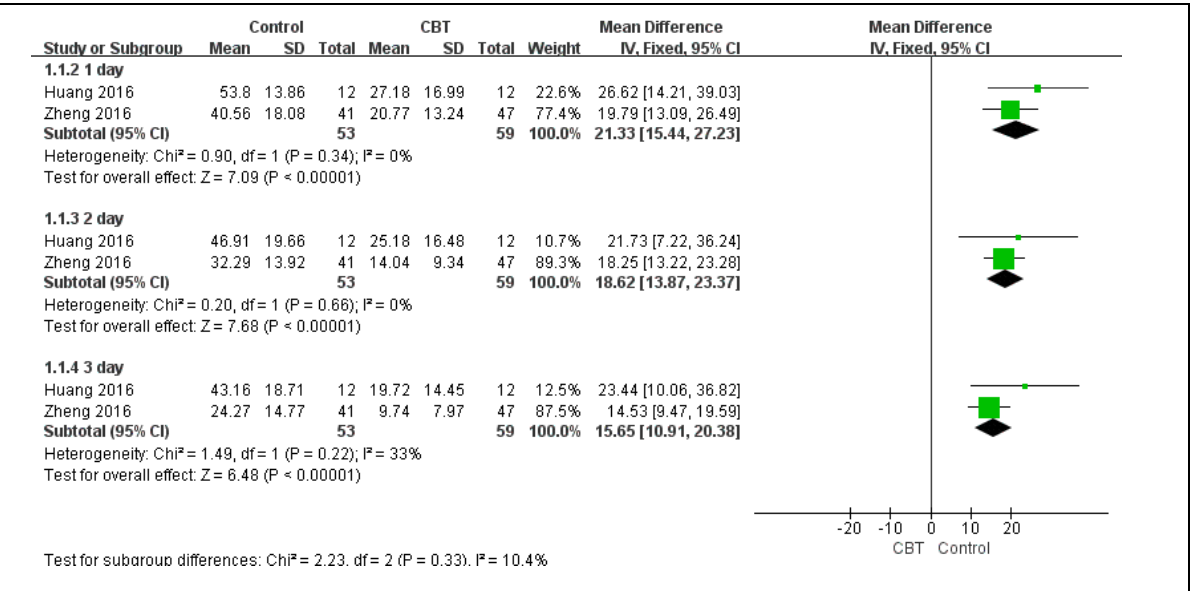
Supplementary Figure 2. Music therapy and control groups for meta-analysis results, reported in